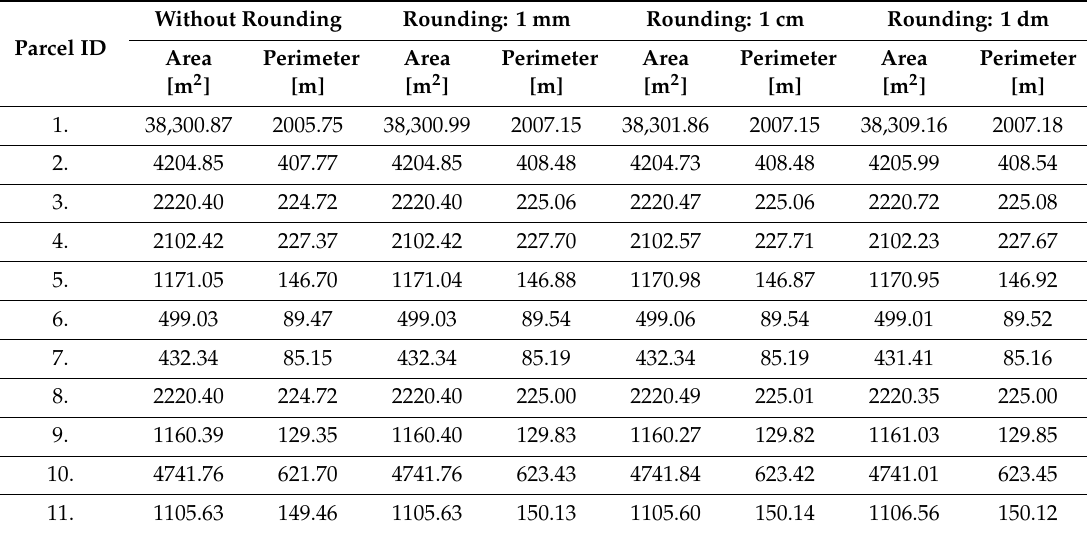
Table 3. Summary of parcel areas for rounded coordinates of approximated